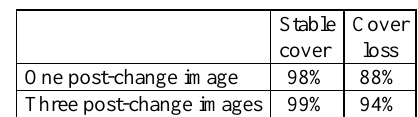
Table 3 . Accuracies of best model with varying number of post- change input data images.